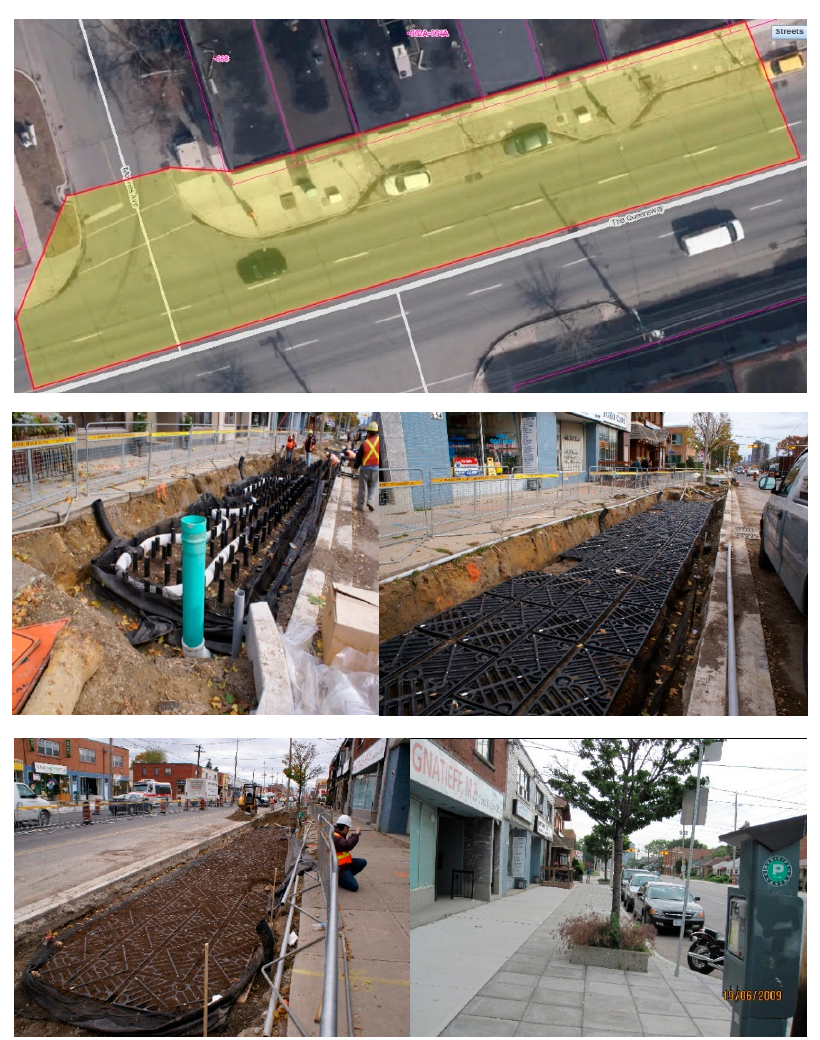
Figure 2. Construction phases of the Toronto underground RBR without a surface layer.